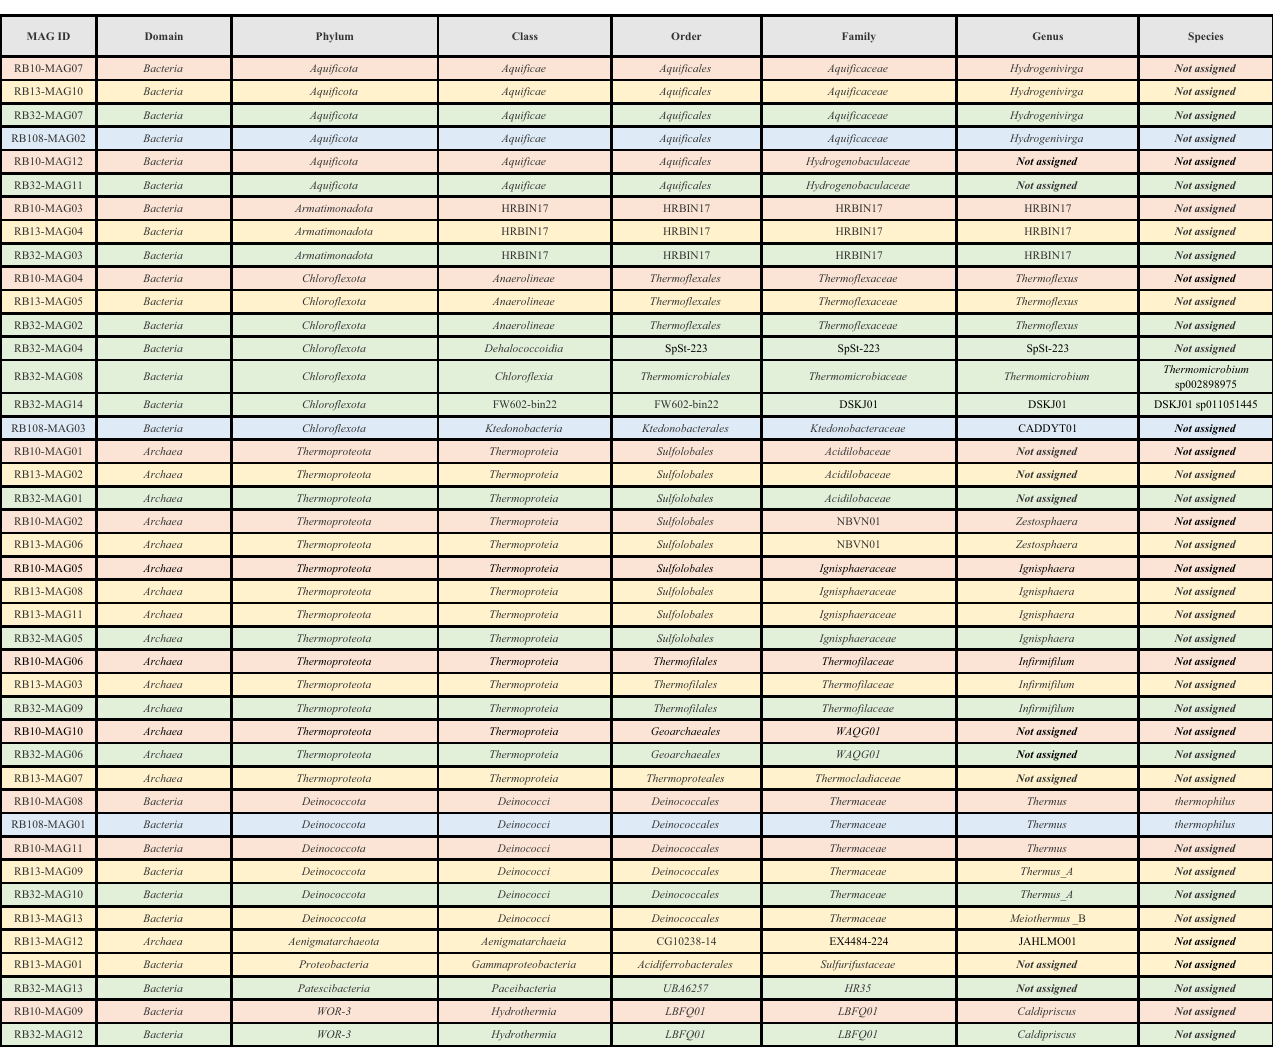
Table 2. Classification of the MAGs based on the taxonomic classification of GTDB-Tk software (v2.1.0) and the Genome Taxonomy Database (07-RS207 release).